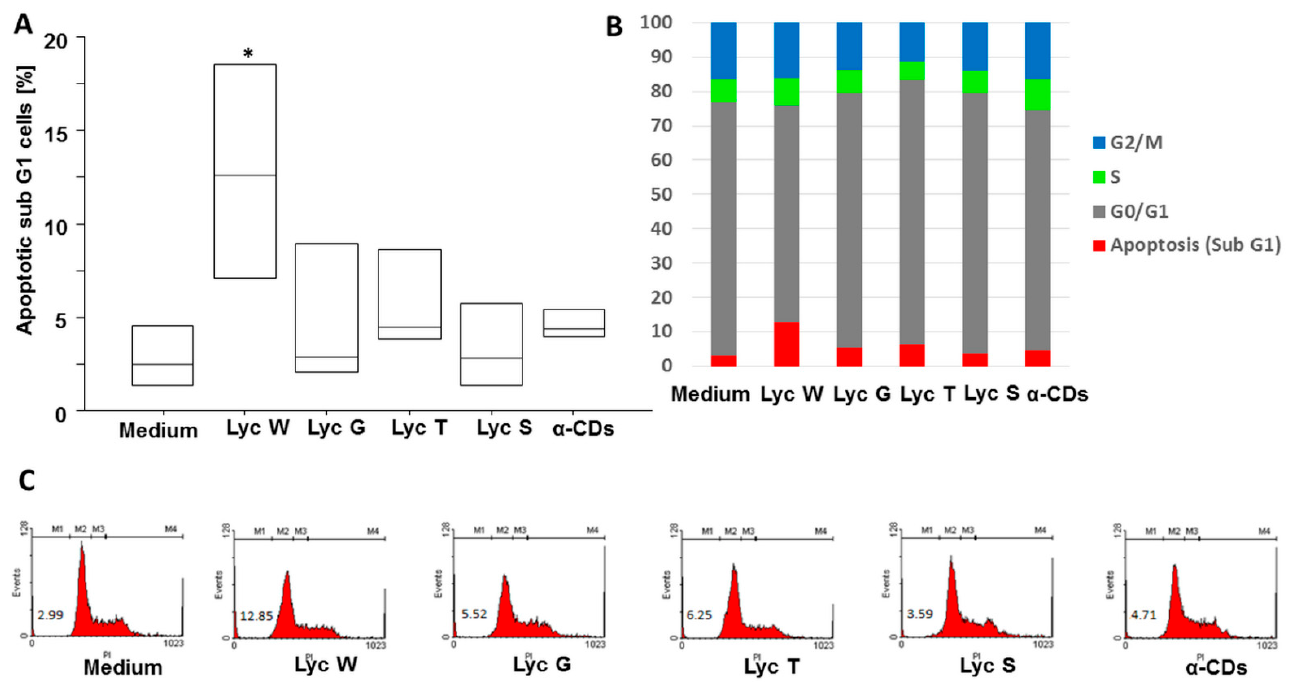
Figure 1. Flow cytometry analysis on A549 cells for cell cycle. ( A ) Lyc W significantly increased the apoptotic cells in comparison to medium, Lyc G, Lyc T, Lyc S and to its carrier α -CDs. The results are shown as box-plots with medians (lines inside the boxes). Analysis of variance (ANOVA), Fisher’s PLSD, n = four experiments; *, p -value < 0.05 ( B ) Representative graph bar with means for M1, Apoptosis (Sub G1), M2, G0/G1, M3, S, M4, G2/M; ( C ) Representative examples of flow cytometric analysis. The numbers indicate the percentage of positive cells.